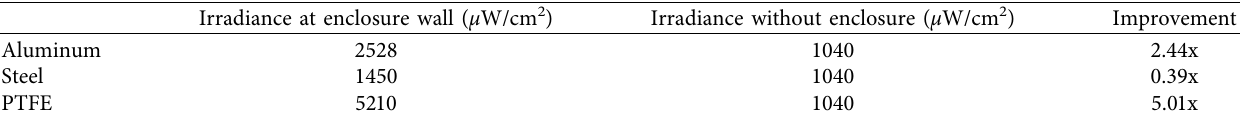
Figure 6: Manufactured enclosures aluminum (left), steel (middle), and PTFE (right). One of the assembled enclosures is also shown with the control electronics in the Table 5: Irradiance measurements at the enclosure wall for different enclosure materials.